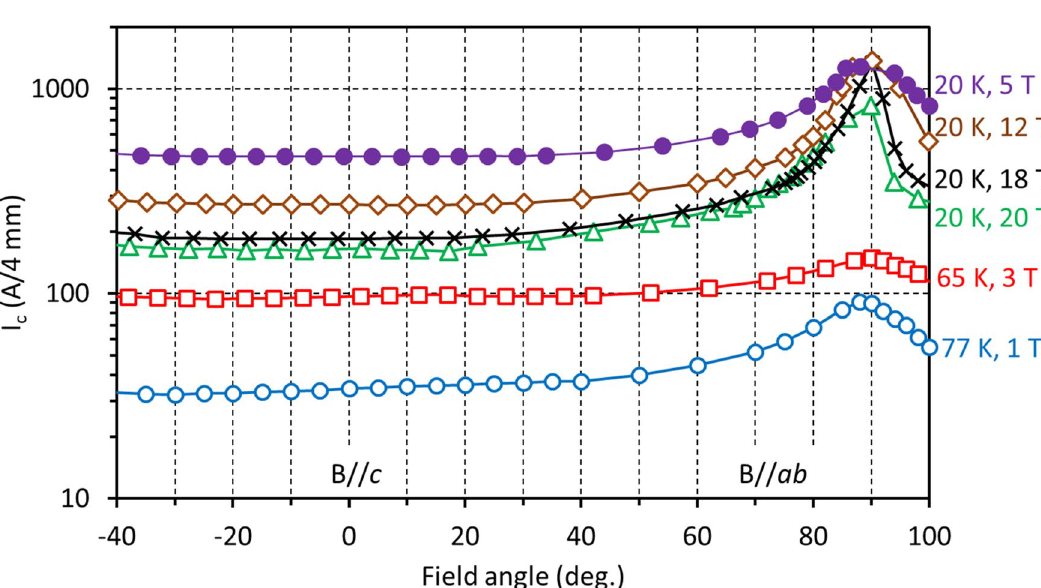
Figure 2. Angular dependences of I c in magnetic field of YBCO wire at 77 K, 1 T; 65 K, 3 T and 20 K, 5, 12, 18, and 20 T. Measurements were performed at Tohoku University. 0° corresponds to the B//c orientation and 90° corresponds to the B//ab orientation. Within the accuracy of measurement, the minimum value of I c for all field orientations is at B//c . At 20 K, I c at B//ab stays almost constant with increasing magnetic field. We believe the smaller value of I c at B//ab at 20 T may be an artefact due to the sharp I c angular peak and the discrete angle step during ratio of the I c at 20 K, high field to I c at 77 K, self-field), even though I c values ranged quite widely as we developed our ability to make thicker HTS layers 37 . Figure 4a presents the correlation between I c (77 K, self-field) and I c (20 K, 20 T). The 200 points cluster tightly along an average “lift-factor” line with an approximately 15% standard deviation. For wires made on a 40 μm